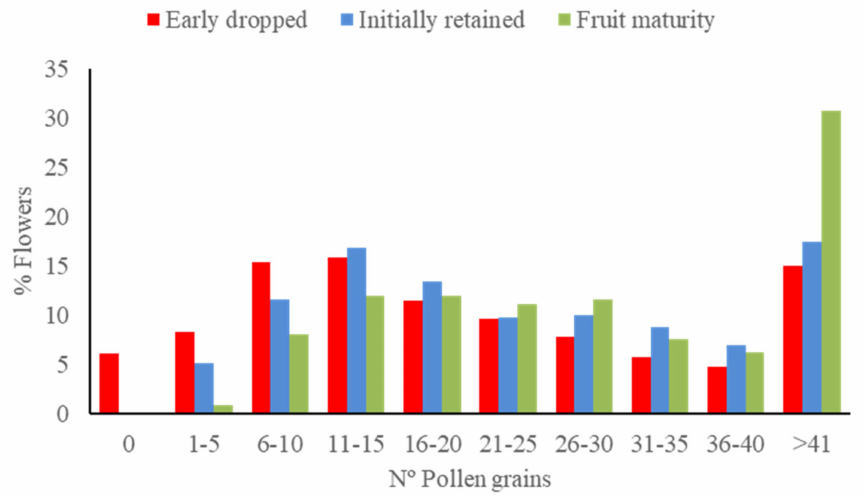
Figure 7. Histogram showing the percentage of avocado flowers into each range of pollen load size on the stigma for each group established based on the fate of the flower/fruit (early dropped, initially retained, and fruit maturity).